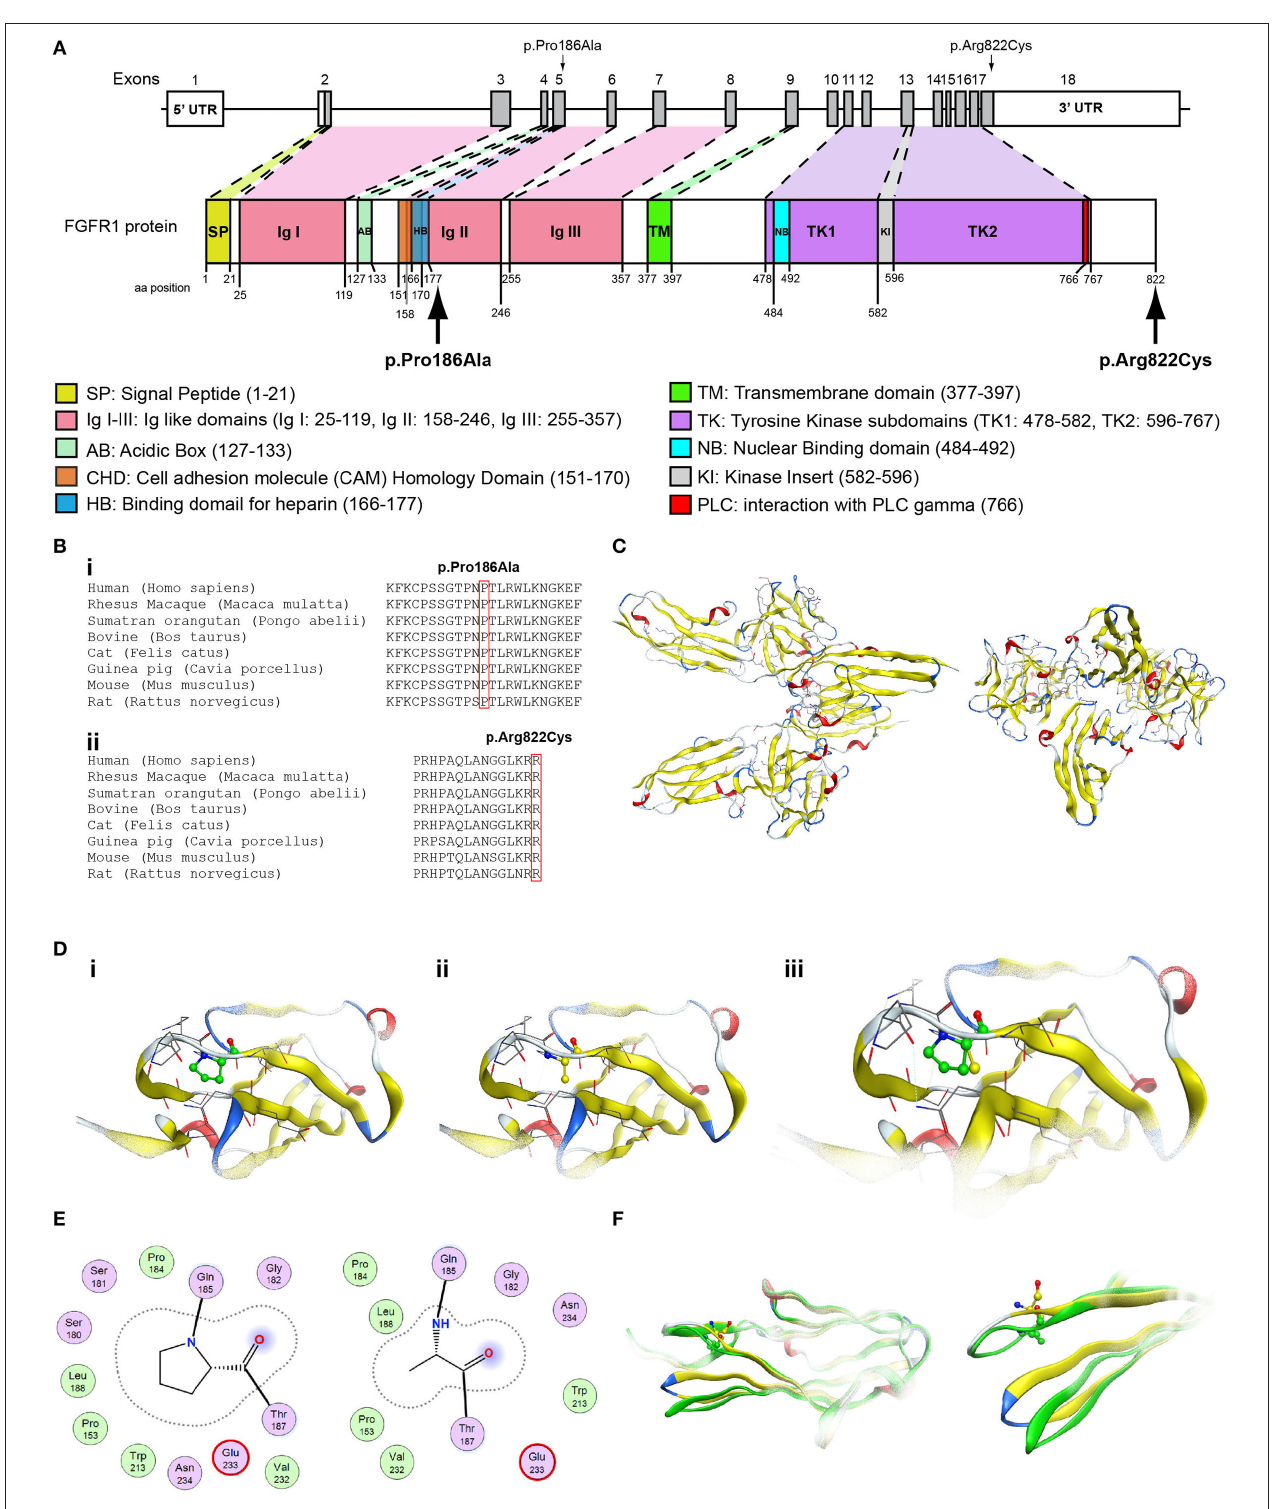
FIGURE 5 | Identification of the p.Pro186Ala and p.Arg822Cys FGFR1 variants. (A) Schematic representation of the FGFR1 gene and protein. The p.Pro186Ala and p.Arg822Cys FGFR1 variants are indicated with arrows. (B) Multiple sequence alignment of the amino acids at position 186 (i) and 822 (ii) of the FGFR1 protein from various species. The conserved amino acids at positions 186 and 822 are indicated by red color. (C) The homology model of the FGFR1. (D) Design of the wildtype (i) and p.Pro186Ala mutant model (ii); the wildtype and p.Pro186Ala mutant models superposed (iii). (E) 2D interaction diagram for wildtype and p.Pro186Ala mutant models. (F) Conformational change induced upon variant. Wildtype is showing in green ribbon, while p.Pro186Ala mutant is showing in yellow ribbon.